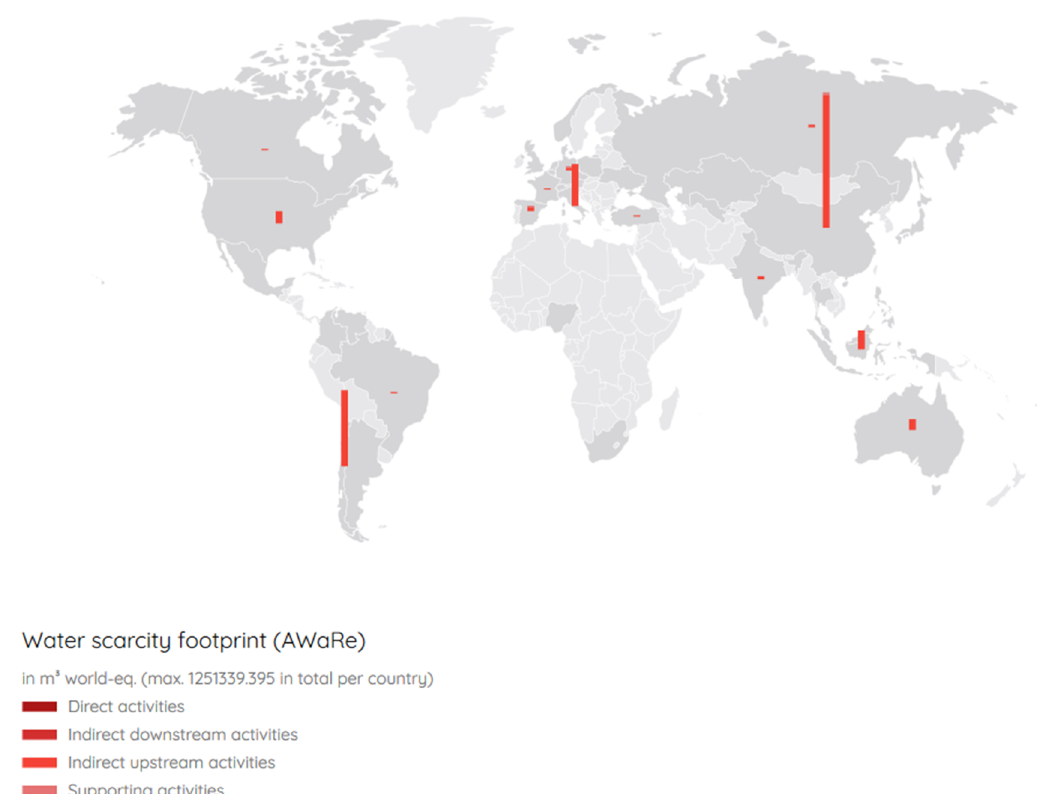
Figure 6. Total water scarcity impacts by location/country. Screenshot from http://wf-tools.see.tu-berlin.de/wf-tools/owf/#/calculation